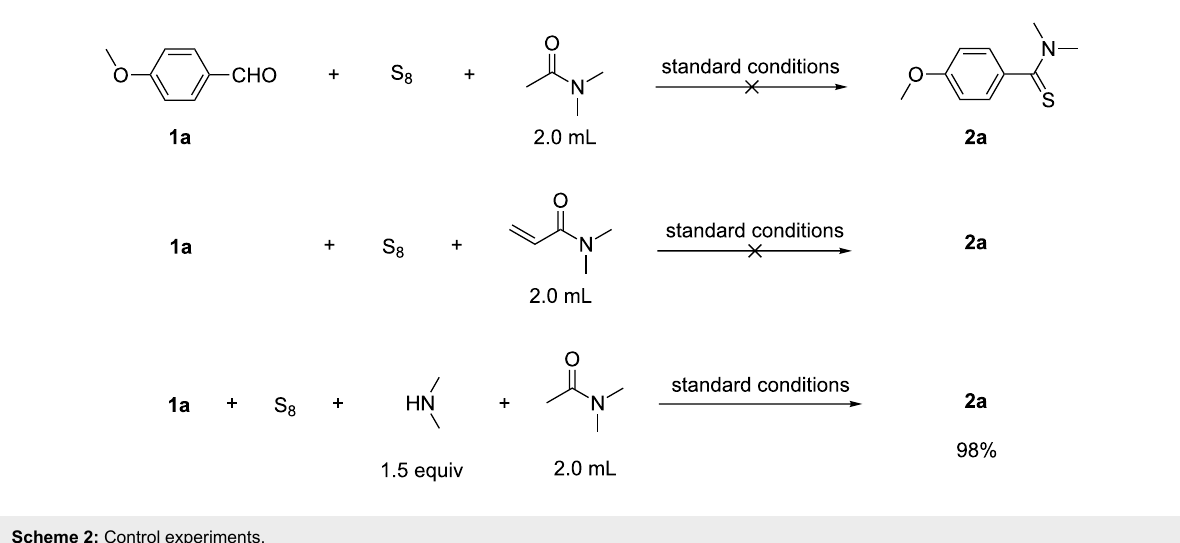
Scheme 2: Control